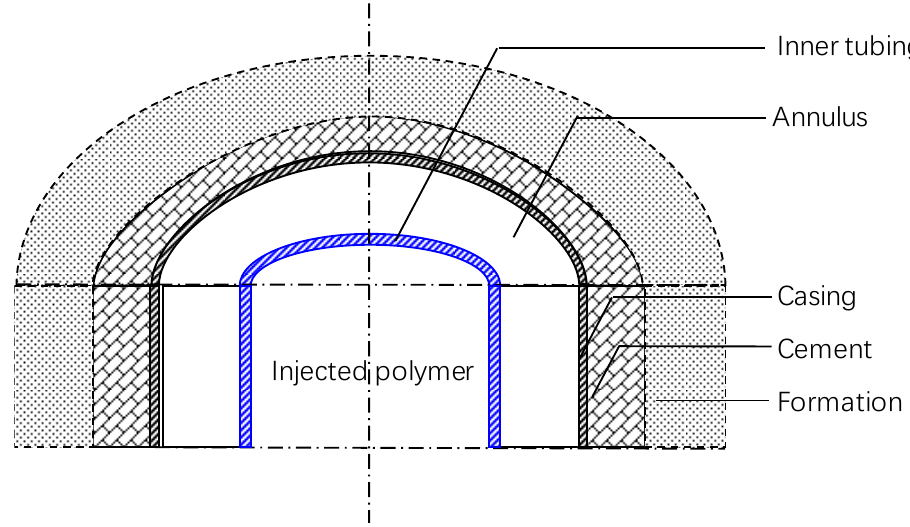
Figure 3. Schematic diagram for normal polymer injection well.